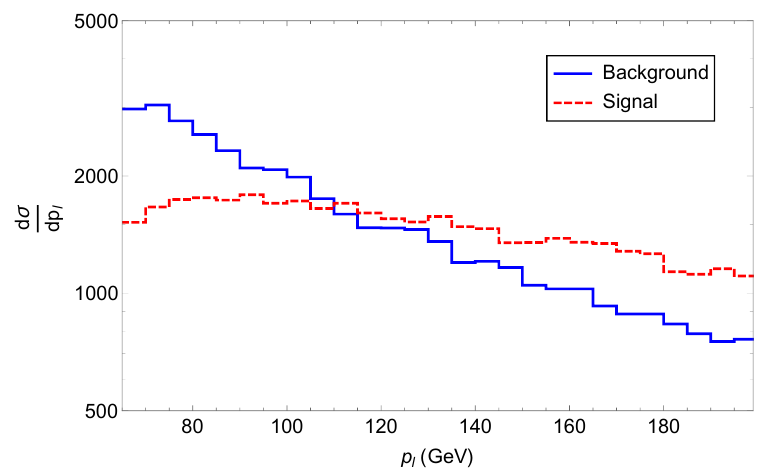
Figure 5. The lepton momentum distribution of the background ( ‘(cid:23) ) and signal ( ‘(cid:30)(cid:31) ) at the partonic level obtained from the Madgraph simulation. For the signal, we use m (cid:31) = 30 GeV and m (cid:30) = 100 GeV. The normalization of the cross section is